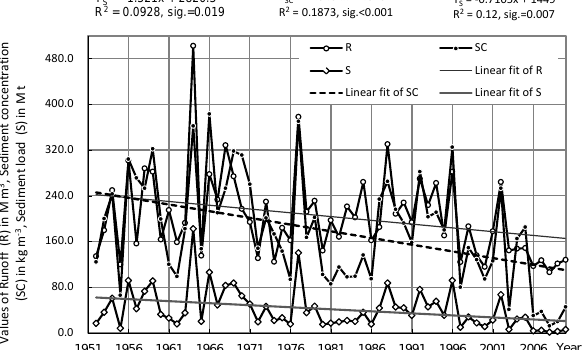
Y SC = -2.3434x + 4820 R 2 = 0.1873, sig.<0.001